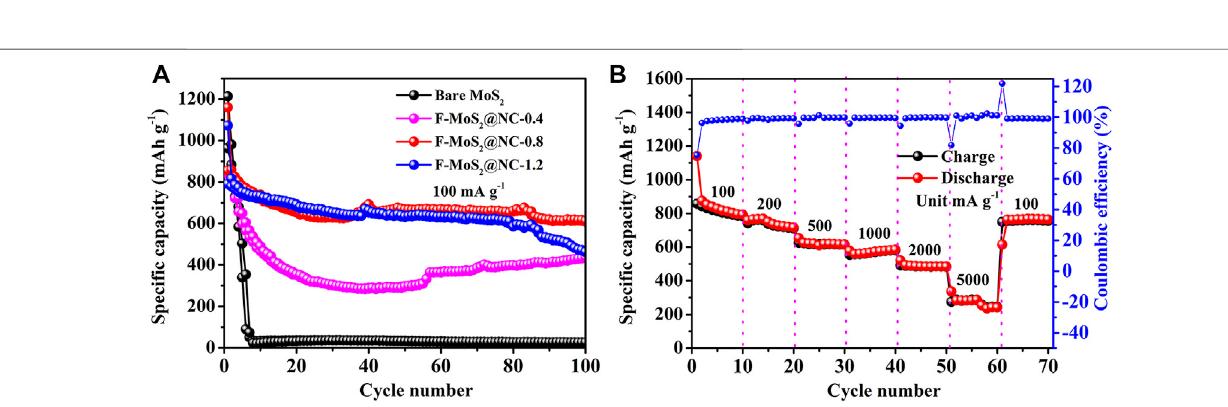
FIGURE 5 | Electrochemical performance of F-MoS 2 @NC as anode of LIBs: (A) CV curves of F-MoS 2 @NC-0.8 electrode at a scan rate of 0.2 mV s − 1 . Charge/ discharge pro fi les of (B) F-MoS 2 @NC-0.8 electrode, (C) F-MoS 2 @NC-0.4 electrode and (D) F-MoS 2 @NC-1.2 electrode at 100 mA g − 1 .